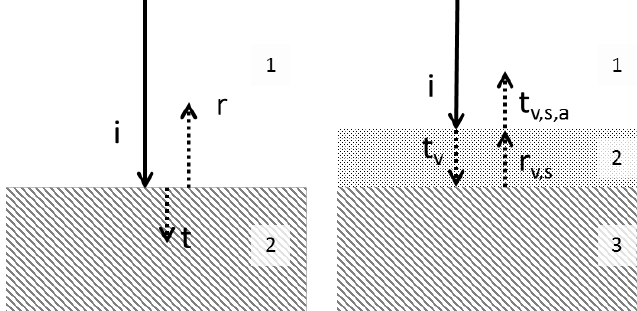
Figure 1. ( Left ) schematics of experiment I of the incoming (i), transmitted (t), and reflected (r) energy between medium 1 (typically air) and medium 2 (soil or vegetation). ( Right ) schematics of experiment II, with three media (1 = air, 2 = vegetation, and 3 = soil) with “t v ” as the transmitted energy from air to vegetation, “r v , s ” as the reflected energy from vegetation to soil, and ”t v , s , a ” as the transmitted energy from vegetation to air (i.e., back to the satellite). Transmitted energy from vegetation to soil and direct reflection from air to vegetation are not